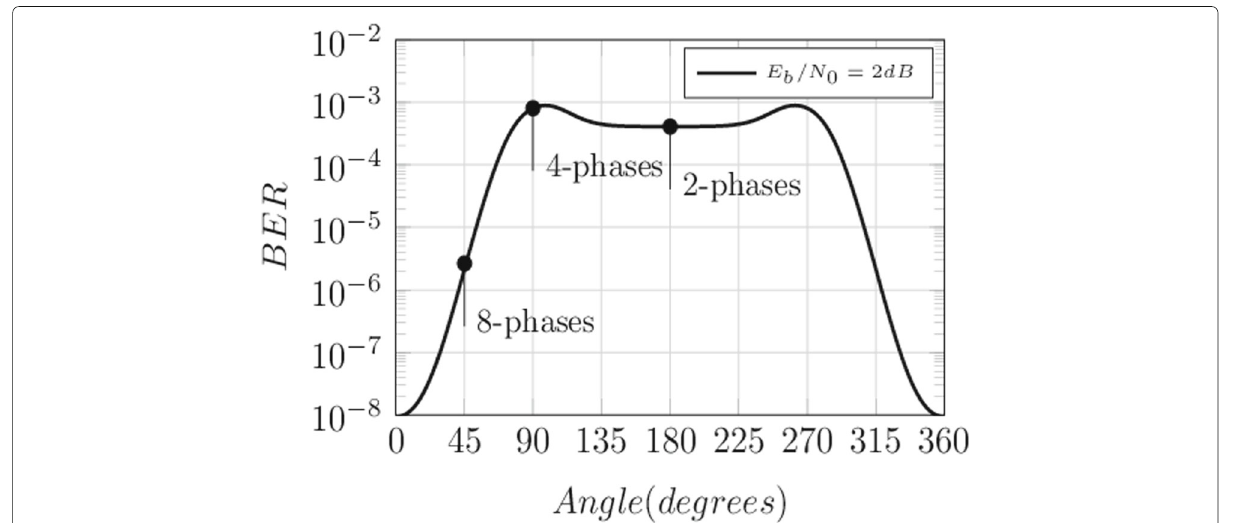
Fig. 8 Analytical BER varying the parameter (cid:4) k (degrees). Higher phase mappings allow better error rate